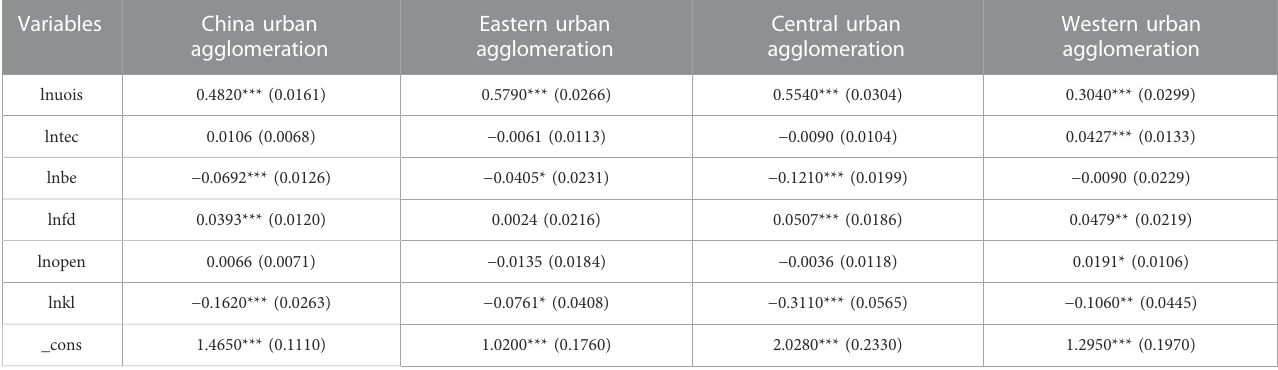
TABLE 5 Regression results of factors in fl uencing